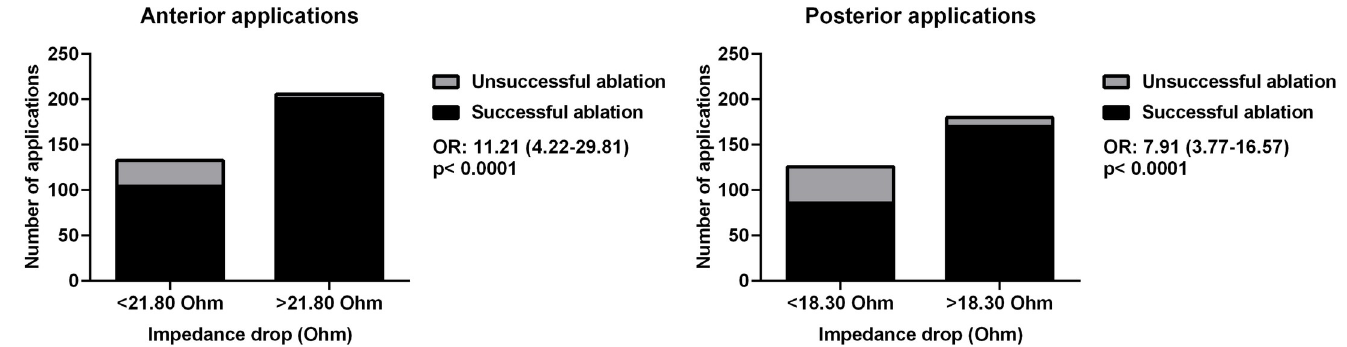
Fig 4. Logistic regression analysis of lesion efficacy on the anterior (left side) and posterior (right side) walls. Abbreviation: OR = odds ratio.